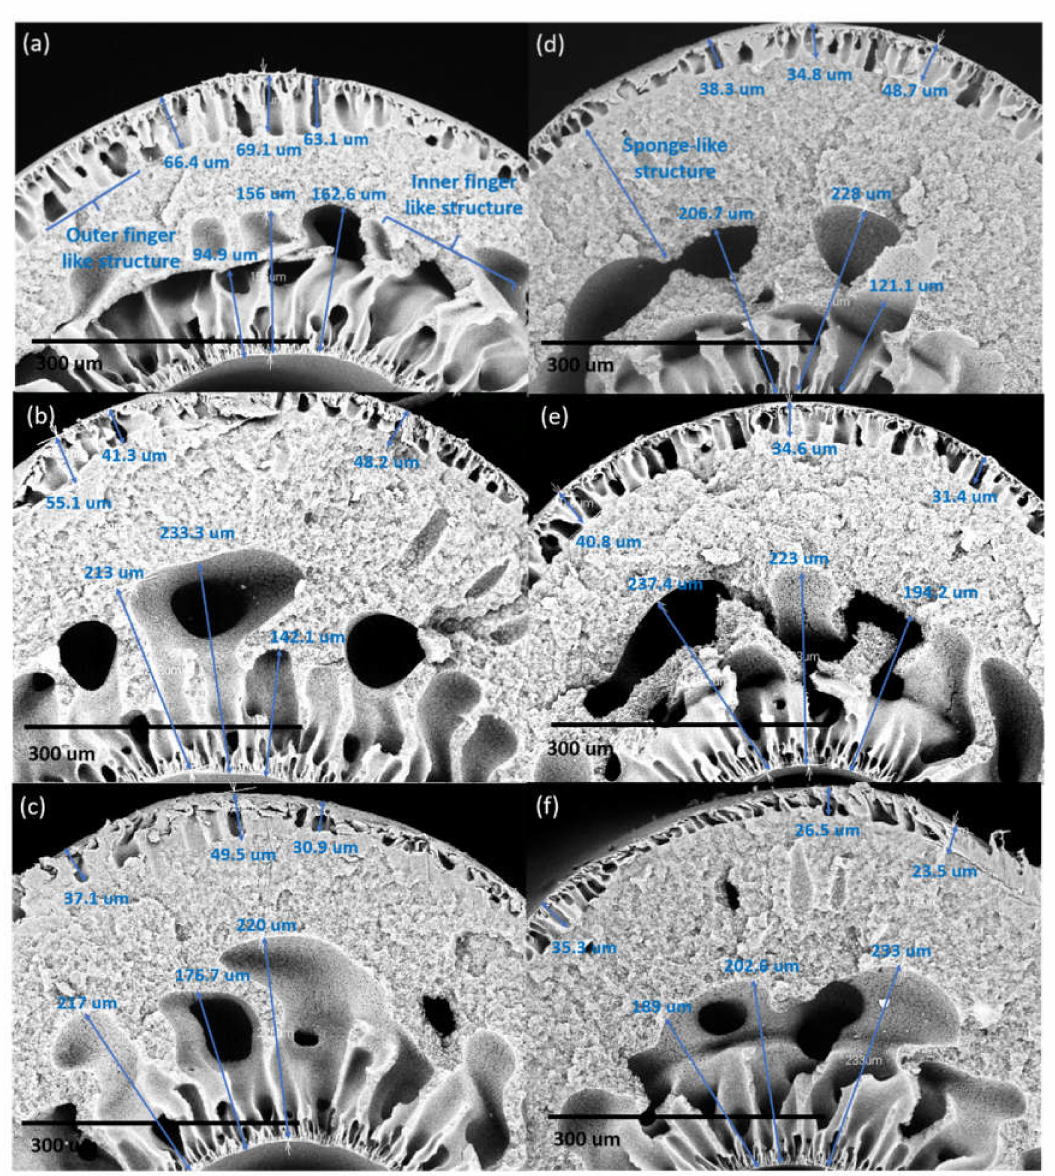
Figure 7. The cross-section ( × 300 magnification) structure of DL-ZT1 membranes spun at di ff erent air gap of ( a ) 5 cm, ( b ) 10 cm, ( c ) 20 cm, ( d ) 30 cm, ( e ) 40 cm, and ( f ) 50